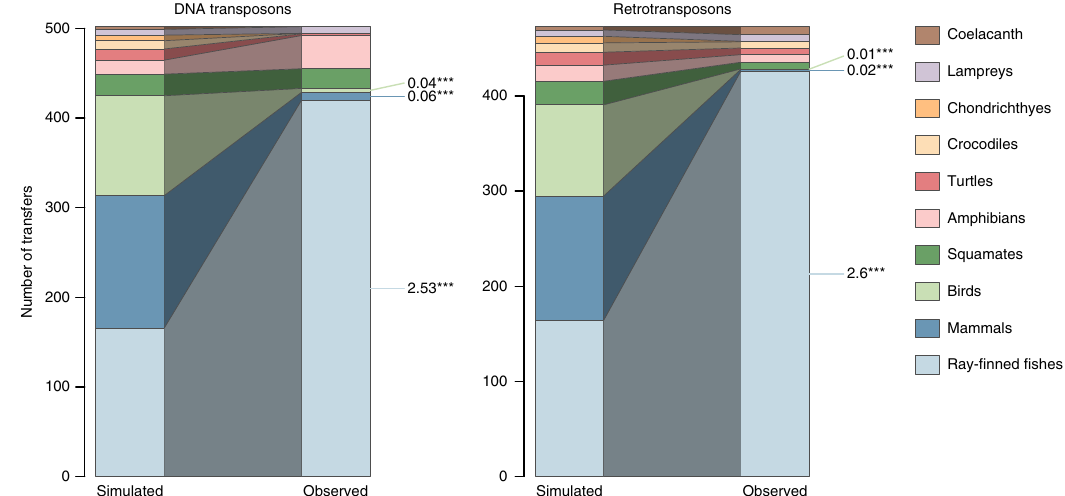
Fig. 3 Contrasting simulated and observed distributions of HTT events involving different vertebrate clades, for the two classes of transposable elements. The left-hand barplot of each graph represents an average over distributions obtained by 1000 random permutations of species involved in HTT. Asterisks indicate clades for which observed numbers of HTT were smaller or higher than those yielded by all permutations ( p < 1 ‰ ), and numbers next to them are ratios between these observed and averaged simulated numbers of HTT events. For other clades, observed numbers were between the 2.5 and 97.5% quantiles of those yielded by permutations ( p >